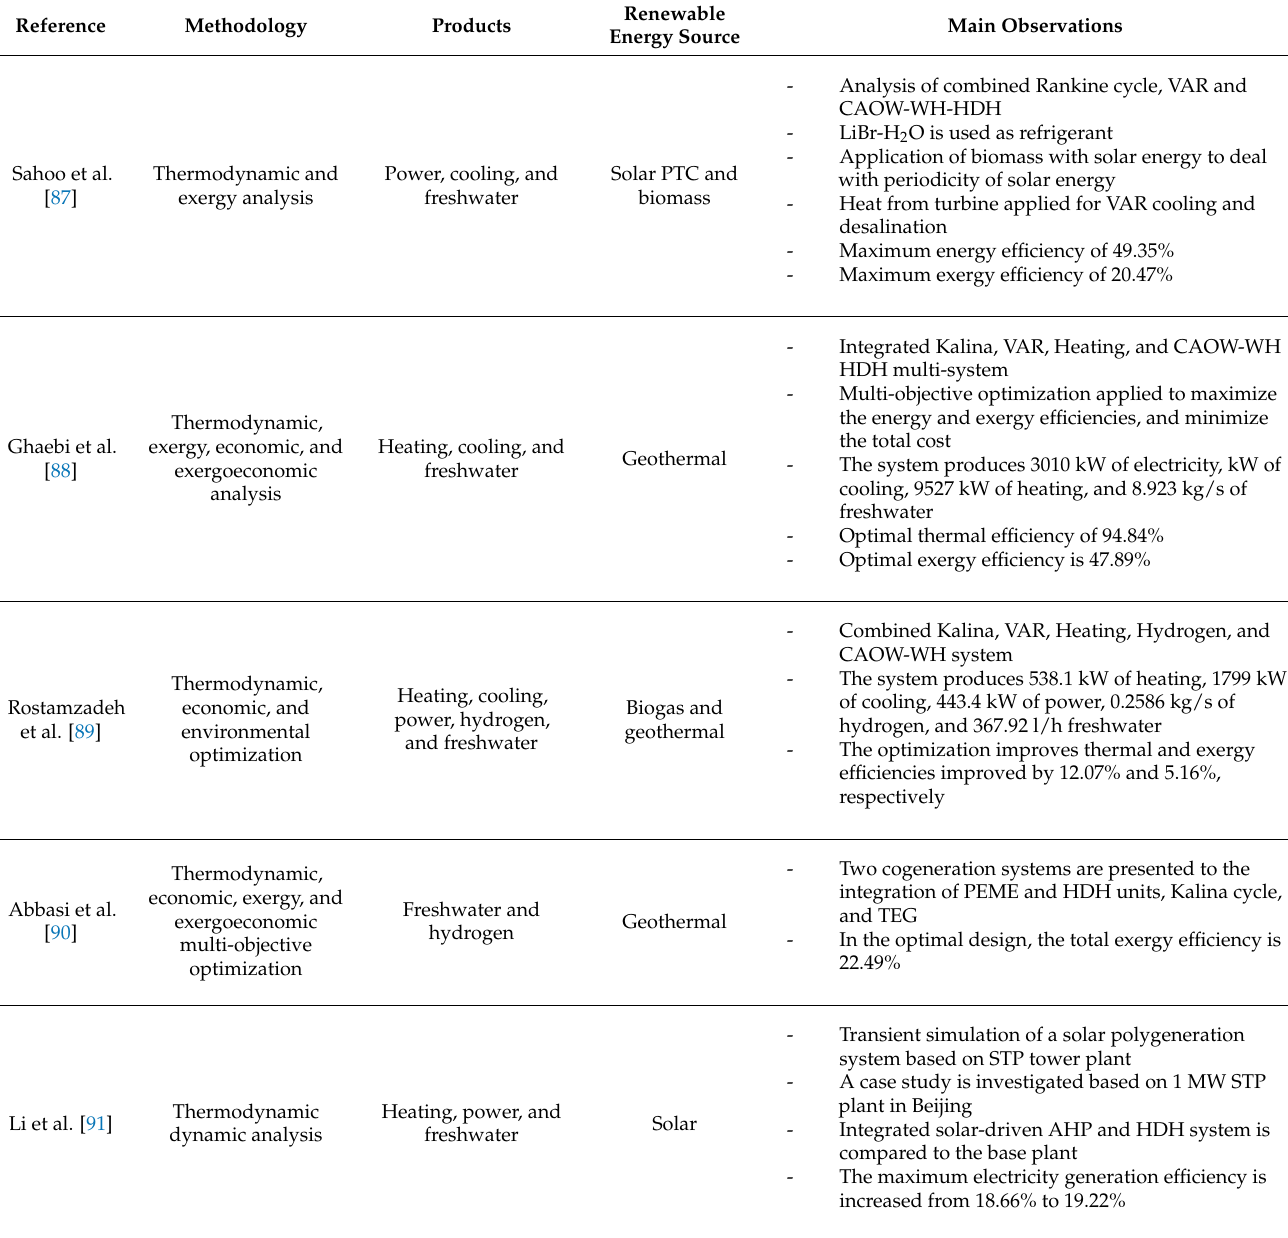
Table 3. Summary of topical research on integrated renewable energy-driven polygeneration and HDH desalination systems.